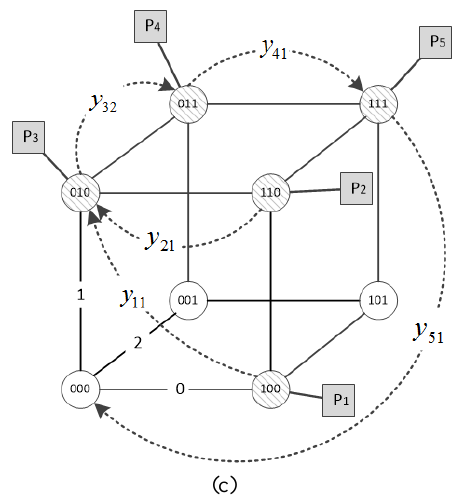
Figure 3. Illustration of decentralized plan execution